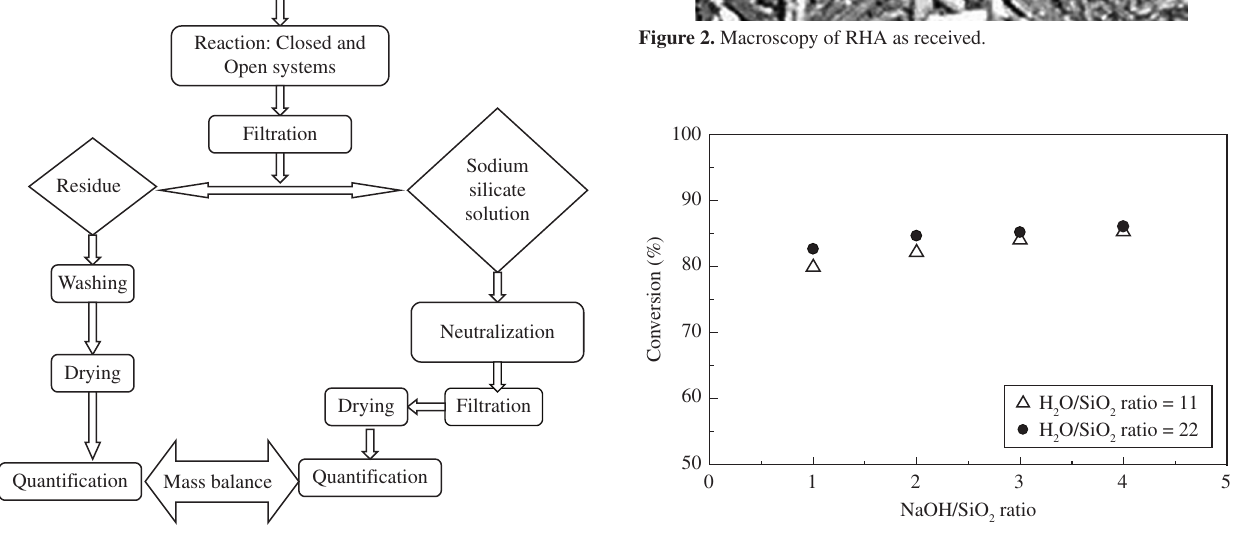
ratio, for H O/SiO 2 2 2